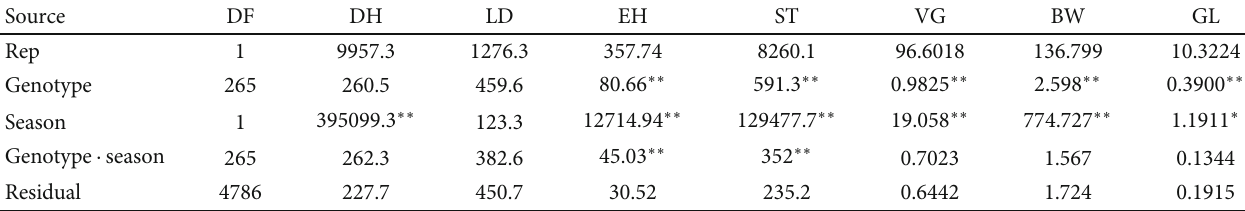
Table 2: Mean squares for Chilo partellus damage and morphological traits at the Kiboko site.